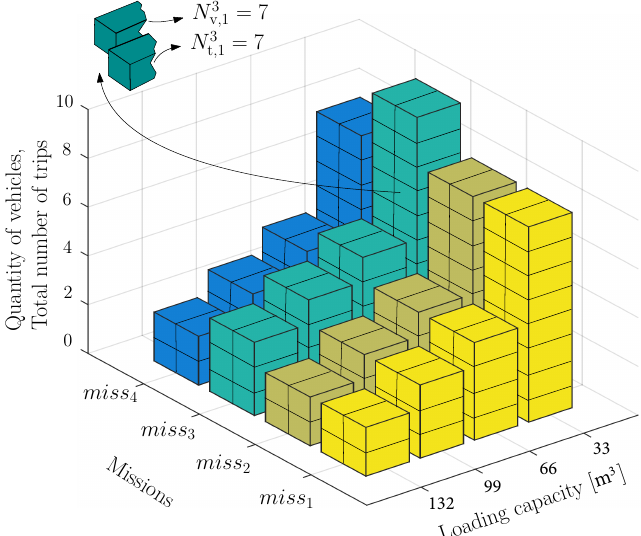
Figure 8. Search space of optimization problem defined by (18)–(27). Vertical bars denote ranges of design